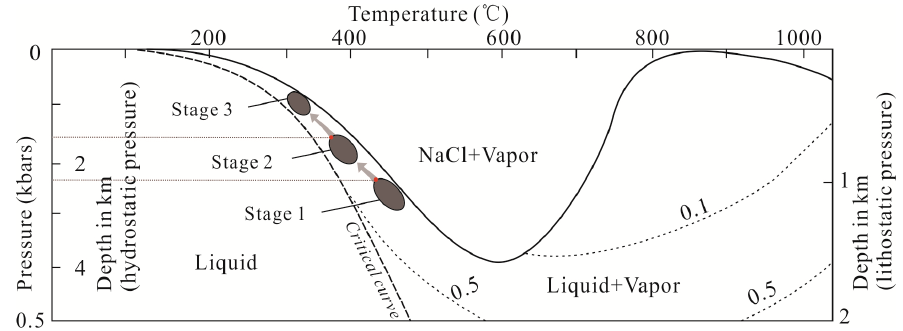
Figure 9. Pressure estimates for fluid inclusions in the Jinchang deposit (adapted from Hedenquist et al. [43] and Redmond et al. [44]).